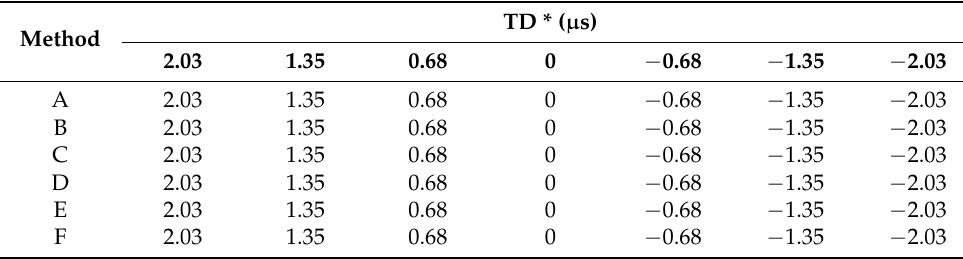
Table 6. The time difference results obtained by using the six algorithms. Method